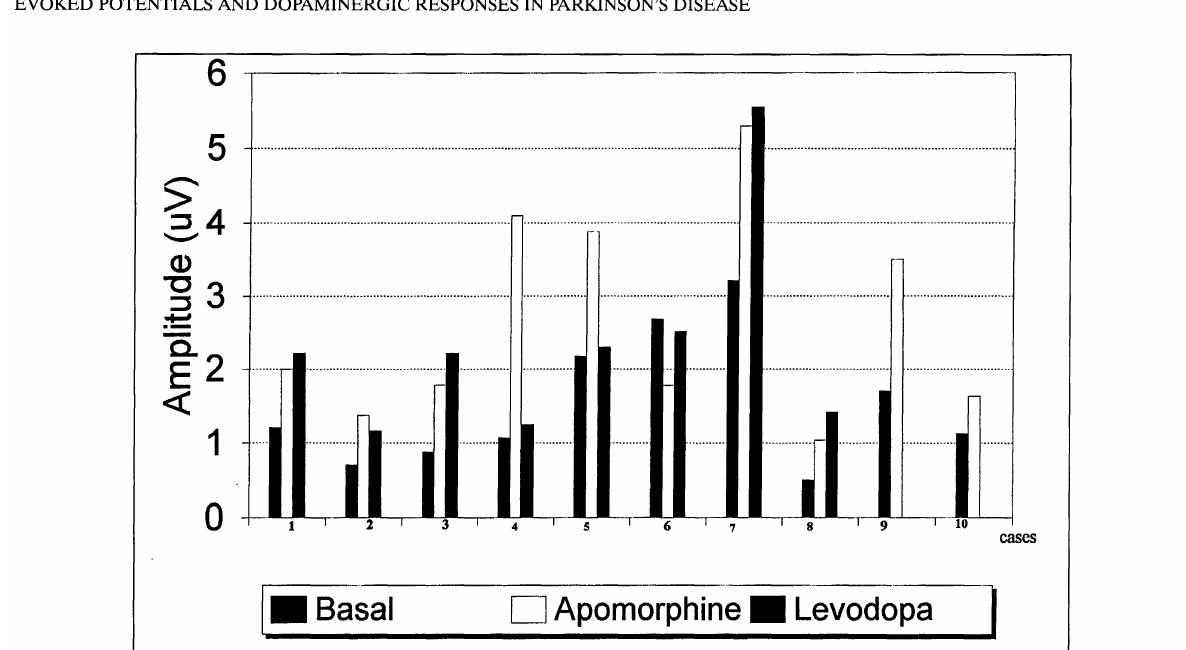
FIG 1, N30 potential amplitude in the 'off' state and after using apomorphine and levodopa in 10 parkinsonian patients, Two patients were tested only with apomorphine (patients 9 and 10)' Both apomorphine and levodopa induced normalization of the N30 potential amplitude except in one patient (patient 6).